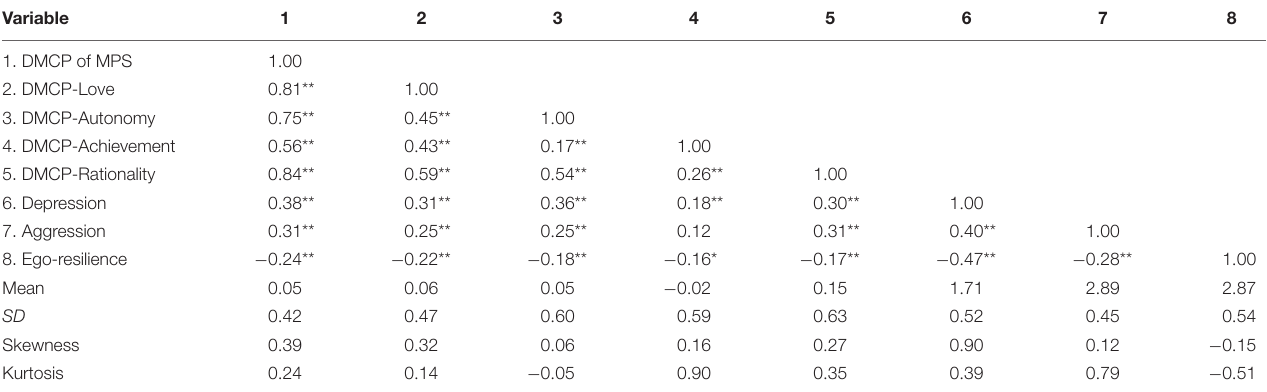
TABLE 3 | Correlation between observed variables.